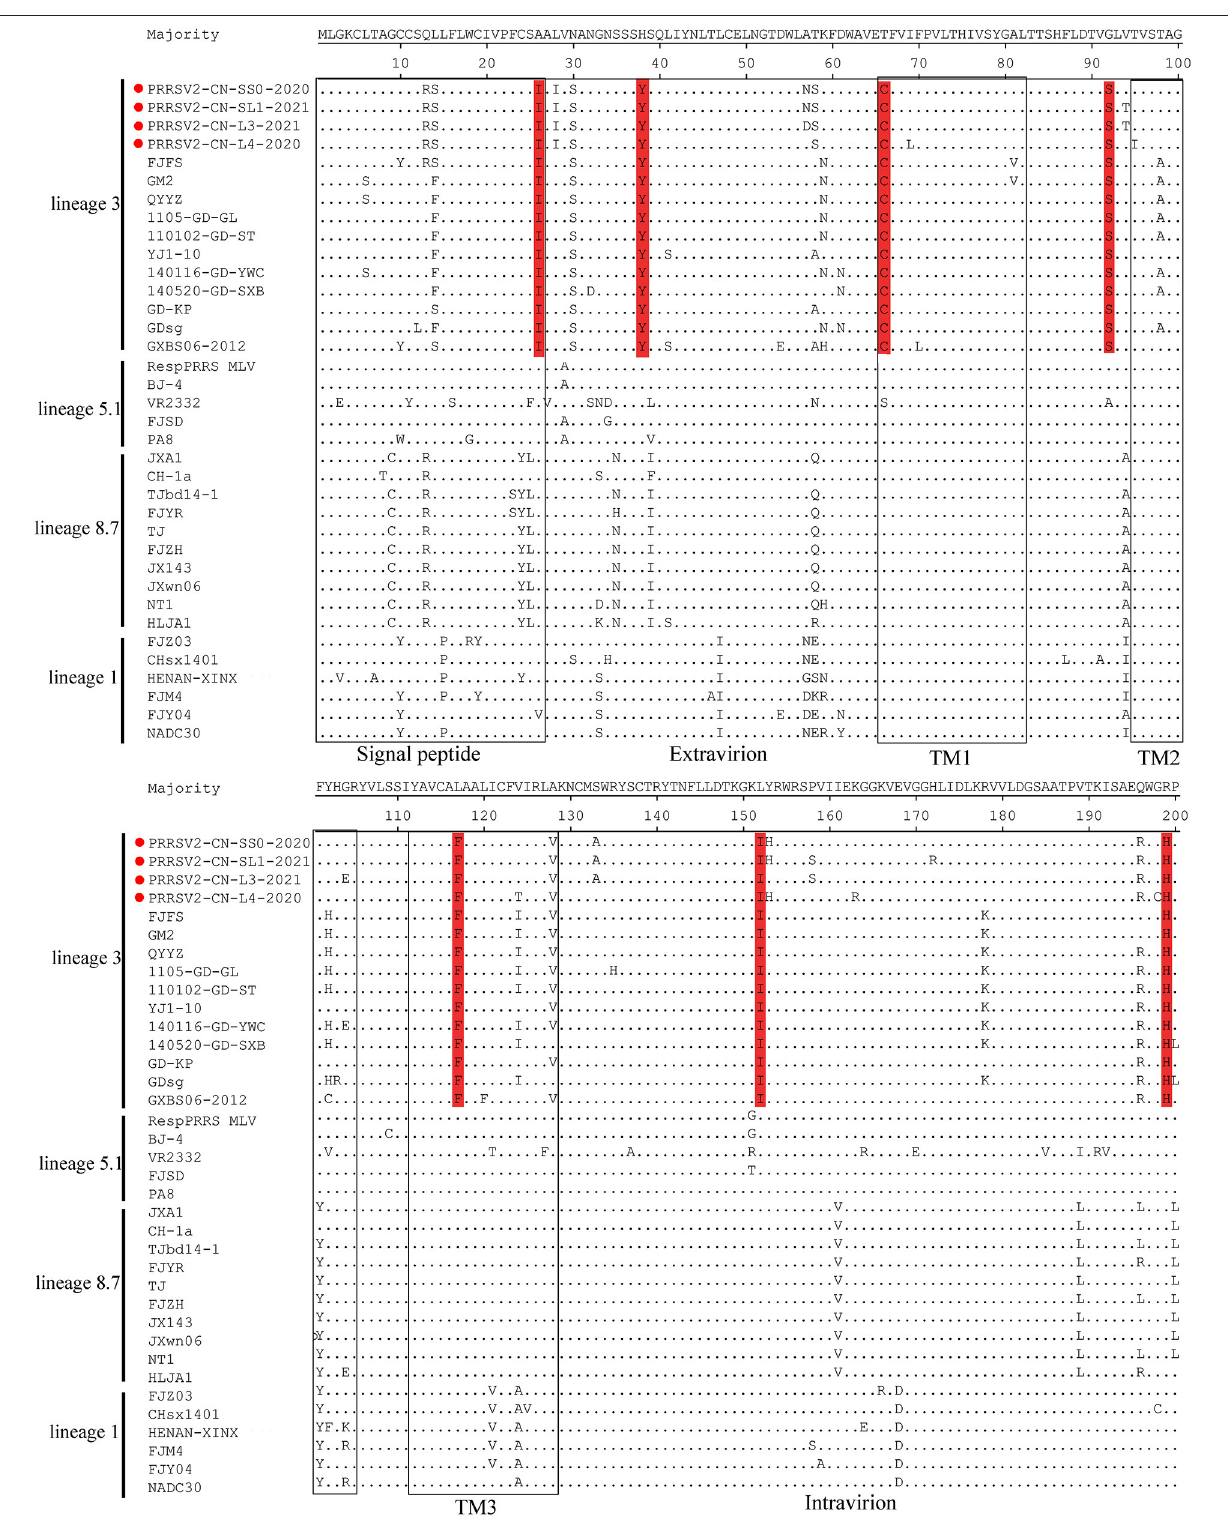
Frontiers in Veterinary Science |